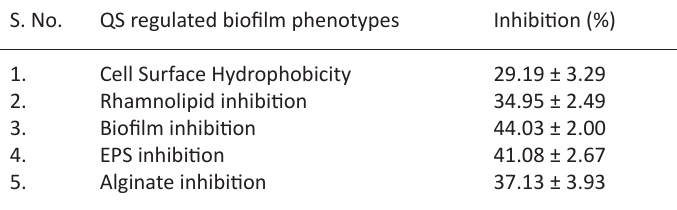
Table 2. List of phytochemicals identified from methanolic extract of P. tenuiflorus using GC-MS analysis